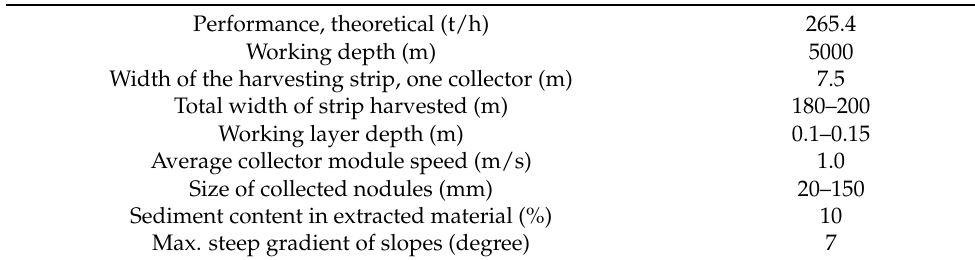
Table 2. Technical characteristics of one collecting